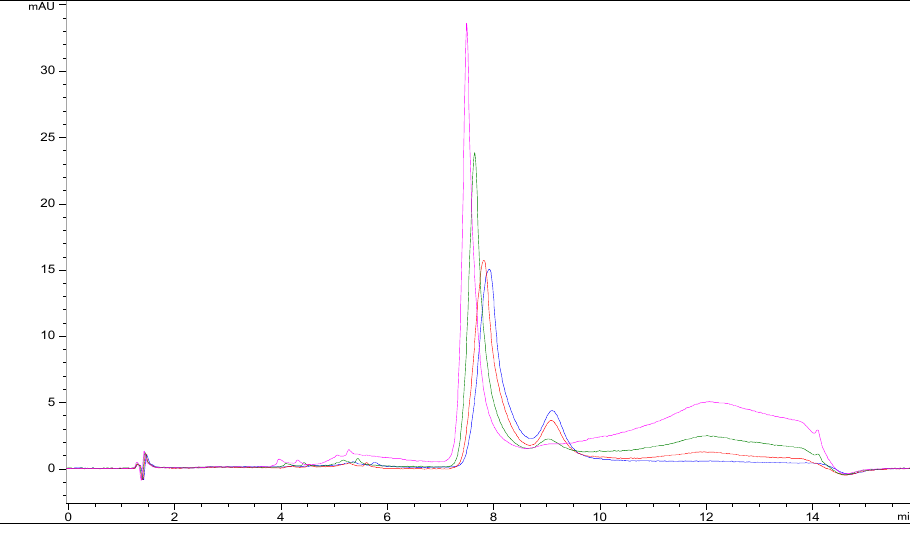
Figure A5. The effect of column temperature on the RP-HPLC chromatograms: −− 30 °C, −− 40 °C, −− 50 °C, and −− 60 °C. Separation was performed on BioZen™ Intact XB-C8 column using 0.1% TFA in water (A) and 0.1% TFA in acetonitrile (B) as a mobile phase at a flow rate of 1.0 mL/min. The gradient program is described in Section 2.2.